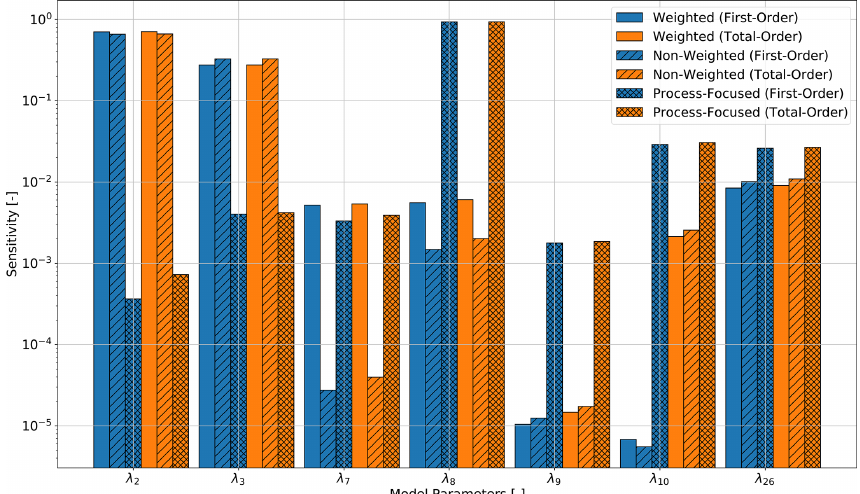
Figure 12. Sensitivity analysis of the unconsolidated and consolidated sediments with different weighting schemes of the hierarchical global sensitivity analysis for the General-Focus Alps model. For the layer IDs and symbols, please refer to Table A1.